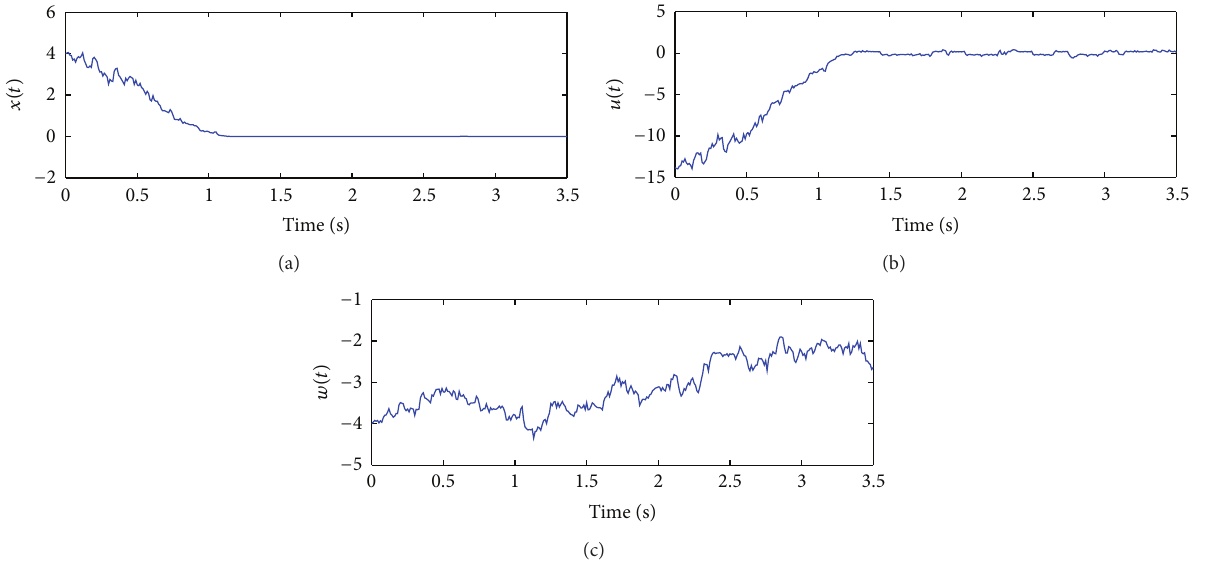
Figure 4: The response of the state 𝑥(𝑡) , the control 𝑢(𝑡) , and the Wiener process 𝑤(𝑡) in Example 1 for initial conditions as 𝑥(0) = 4.